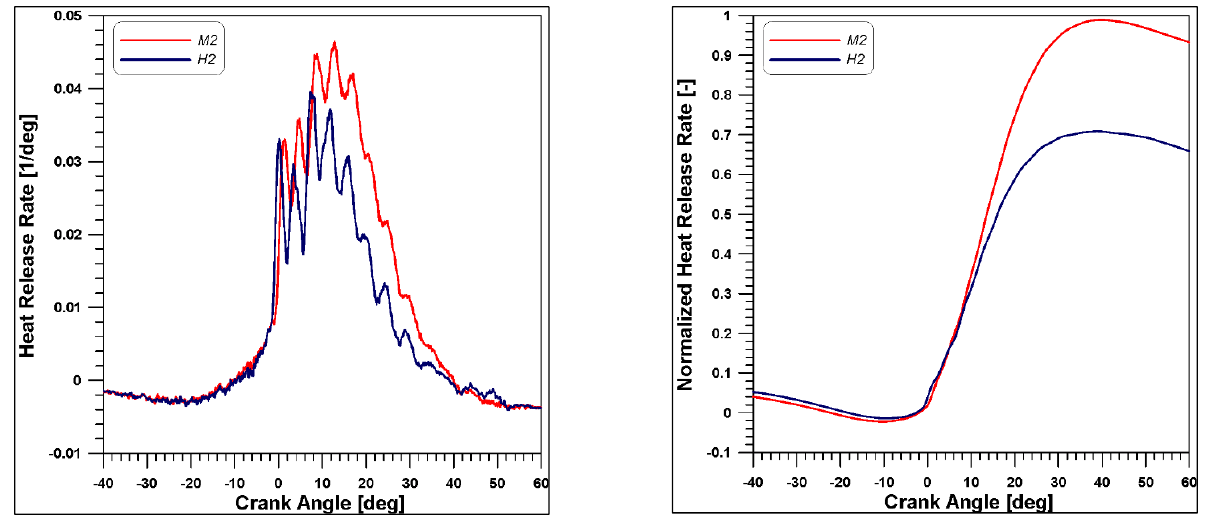
Figure 8. Comparison of normalized heat release rates and accumulated heat release (M3 vs. H4).